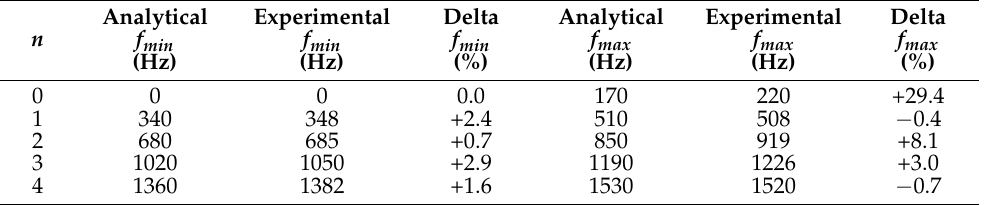
Table 3. Comparison between analytical and experimental f min and f max of TL for the simple expansion chamber.